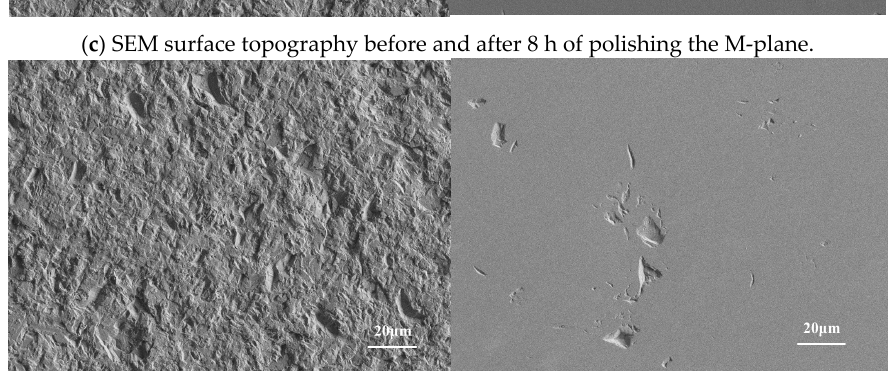
Figure 7. The 500X SEM surface topography with 8 h polishing time of the four crystal orientations